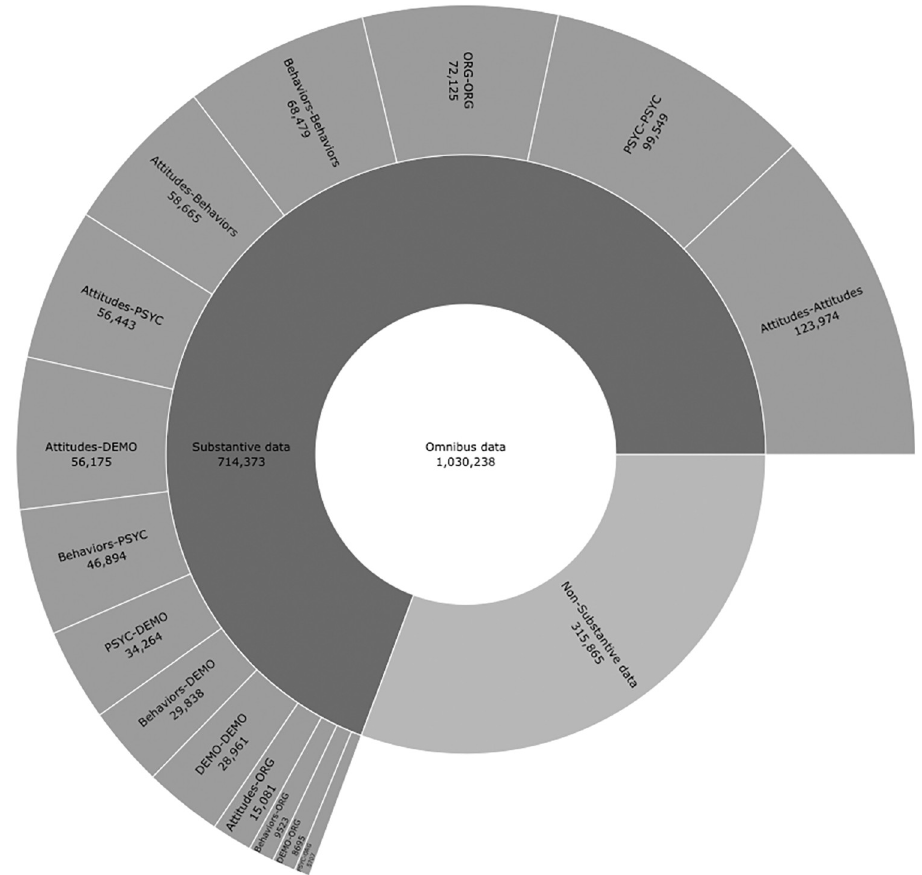
Fig 1. Breakdown of metaBUS dataset. Note . PSYC = Psychological characteristics; DEMO = Objective person characteristics / demographics; ORG = Organizational characteristics. The three smallest regions read (from left to right): Behaviors-ORG ( N = 9,523), DEMO-ORG ( N = 8,695), and PSYC-ORG ( N = 5,707).